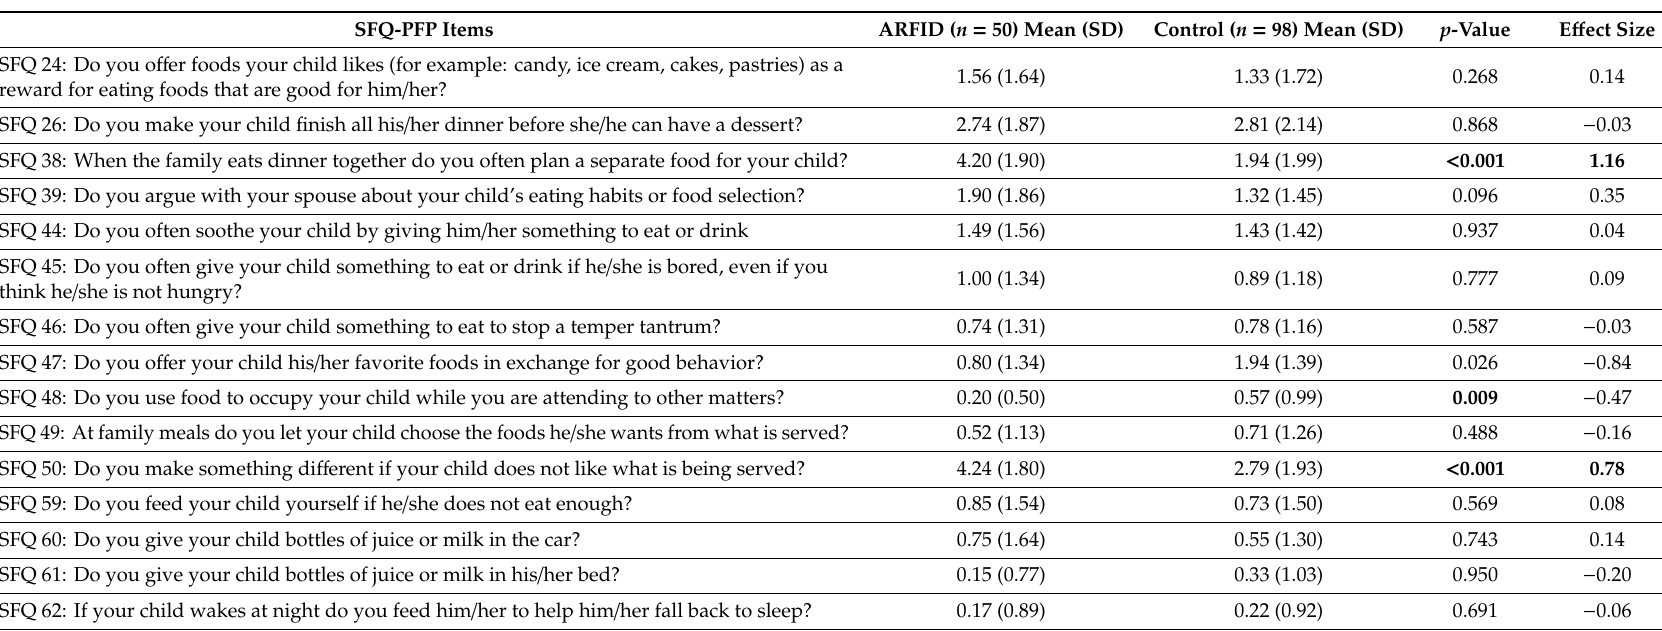
Table 2. Between-group di ff erences of the 15 items in the proposed SFQ-Parental Feeding Problems Scale. SFQ-PFP Items ARFID ( n = 50) Mean (SD) Control ( n = 98) Mean (SD) p -Value E ff ect